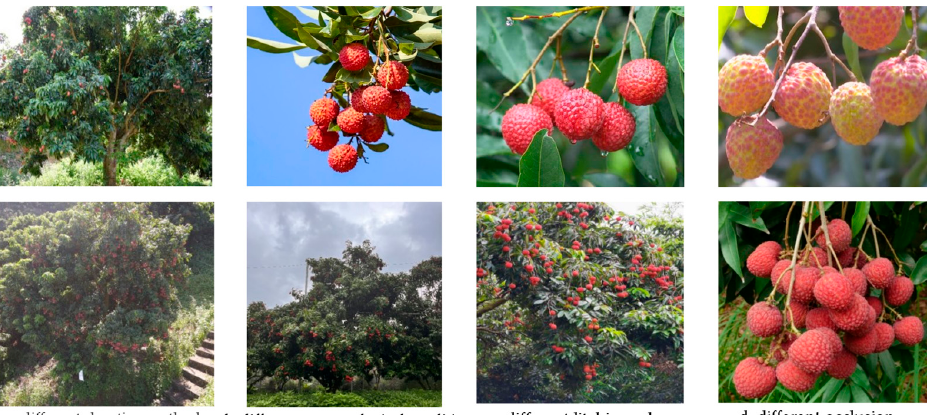
Figure 1. The composition of the dataset.